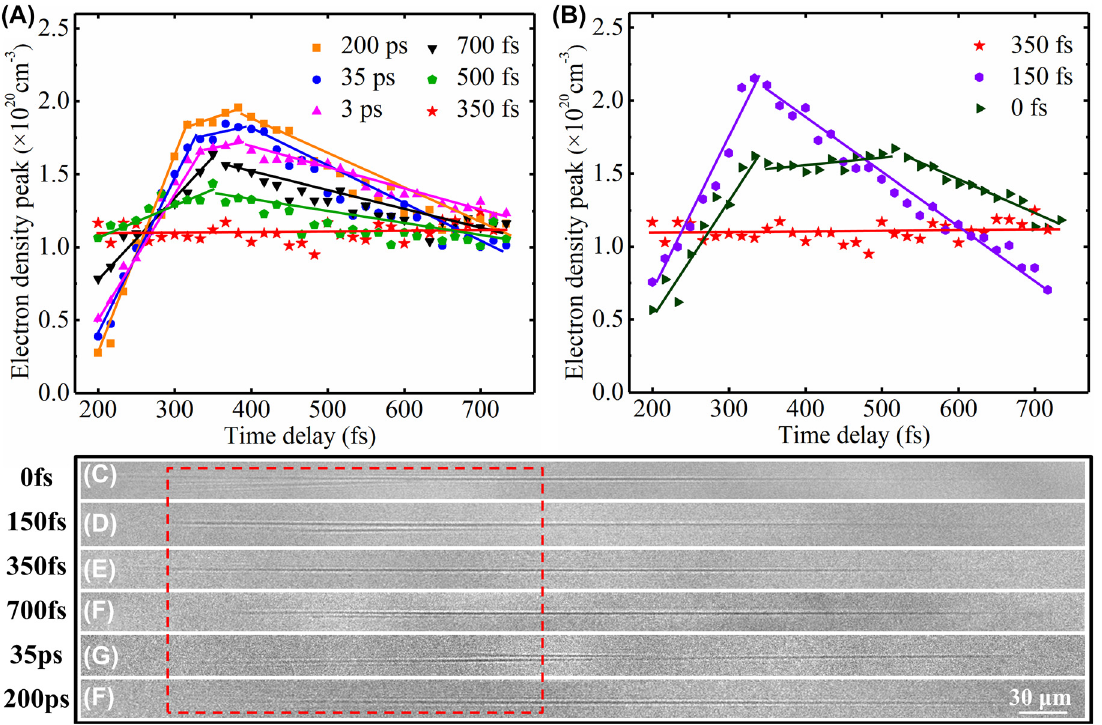
Figure 6: Electron density peak and modified filaments inner fused silica with different double-pulse time intervals. (A, B) Electron density peak for pump-probe delay times of 200–750 fs with double-pulse time intervals ranging from 0 to 200 ps. (C–H) The modified filaments inner fused silica induced by the single-pulse and double-pulse femtosecond laser with time intervals from 0 fs to 200 ps. The laser repetition frequency is 1000 Hz, and the pulse duration is 5